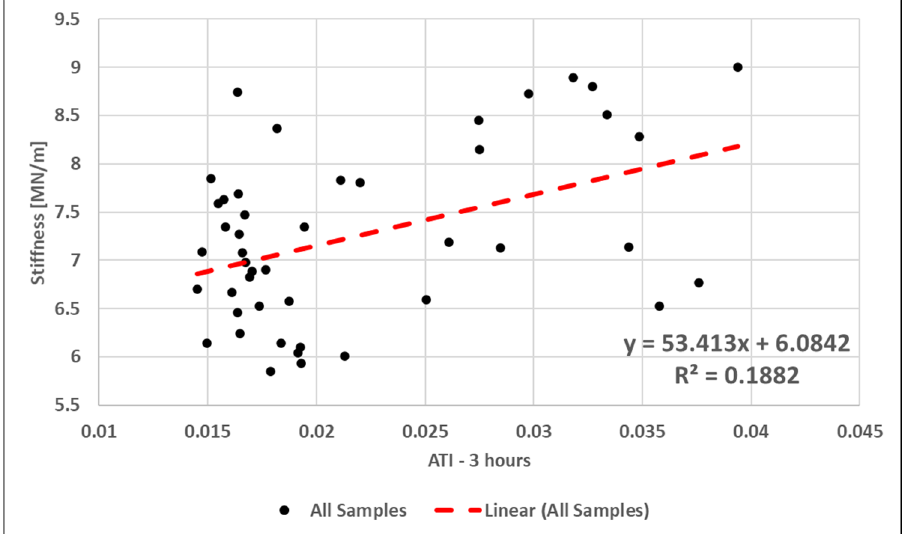
Remote Sens. 2021 , 13 , x FOR PEER REVIEW Figure 7. Plot of all the samples Stiffness (MN/m) verses ATI. Figure 7. Plot of all the samples Stiffness (MN/m) verses ATI.